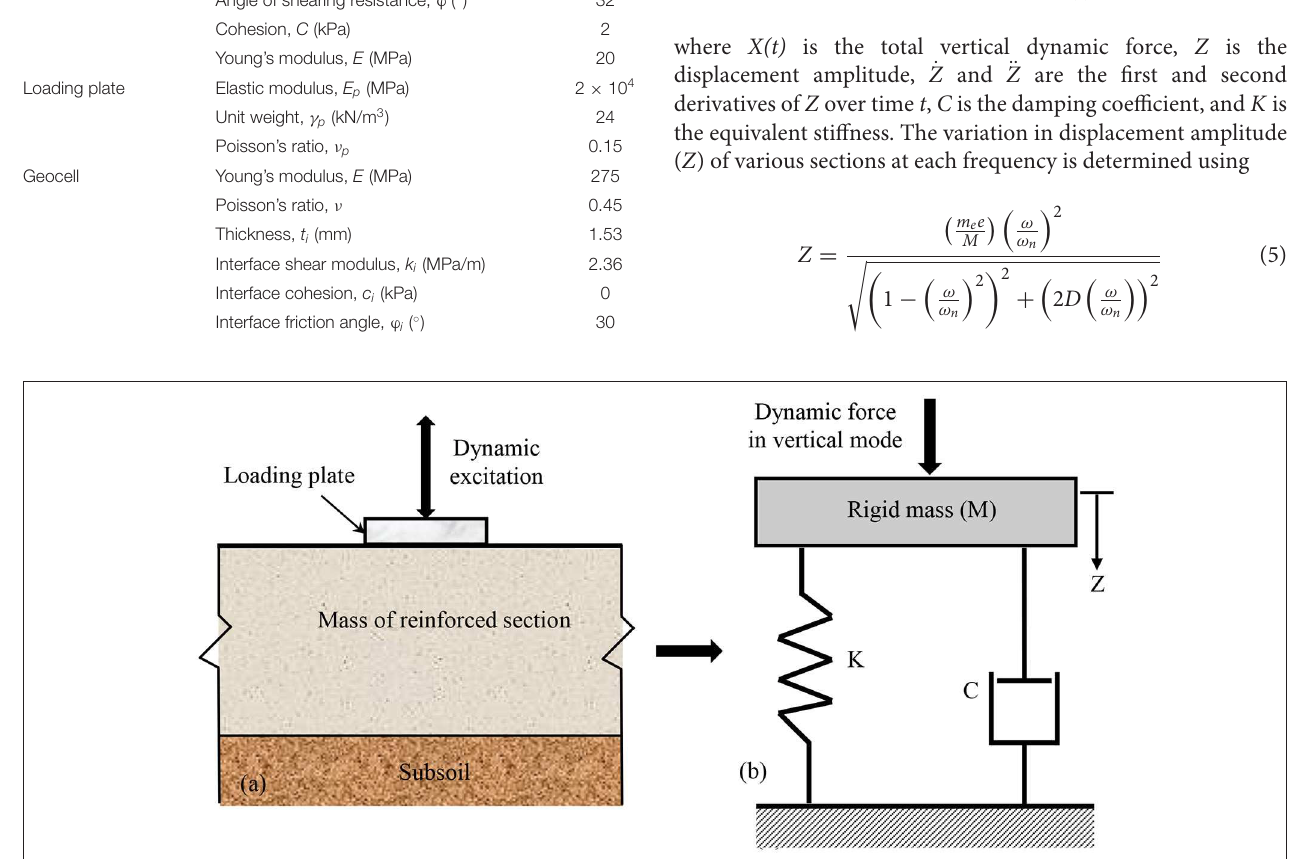
FIGURE 8 | Analogy of a system: (a) actual reinforced subgrade section; and (b) MSD idealization.